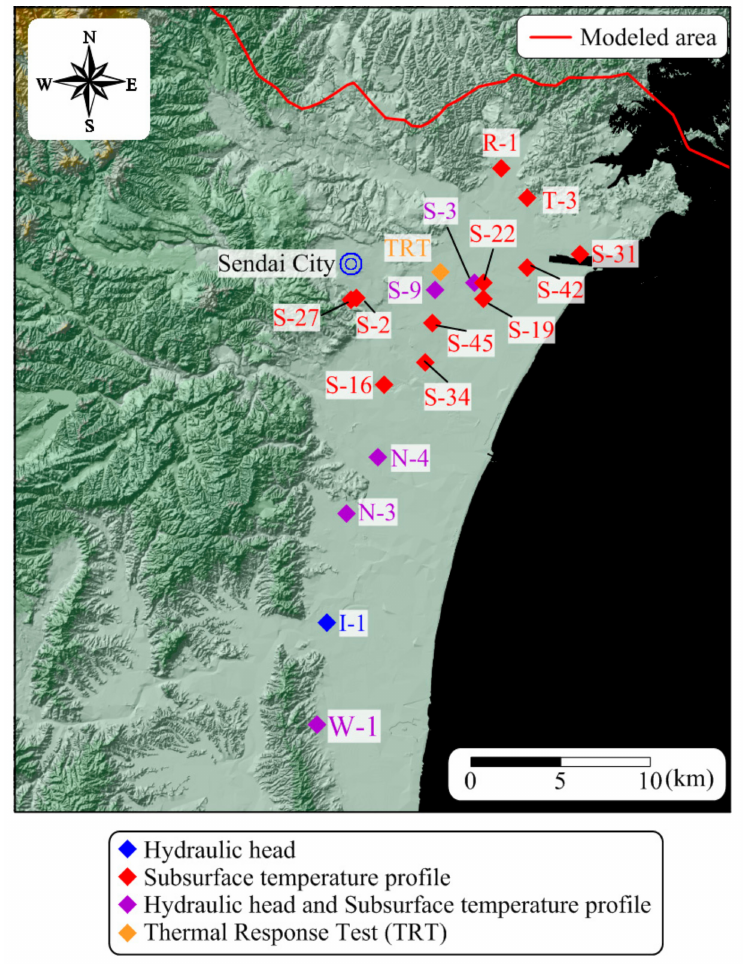
Figure 3. Location of groundwater monitoring wells in the Sendai